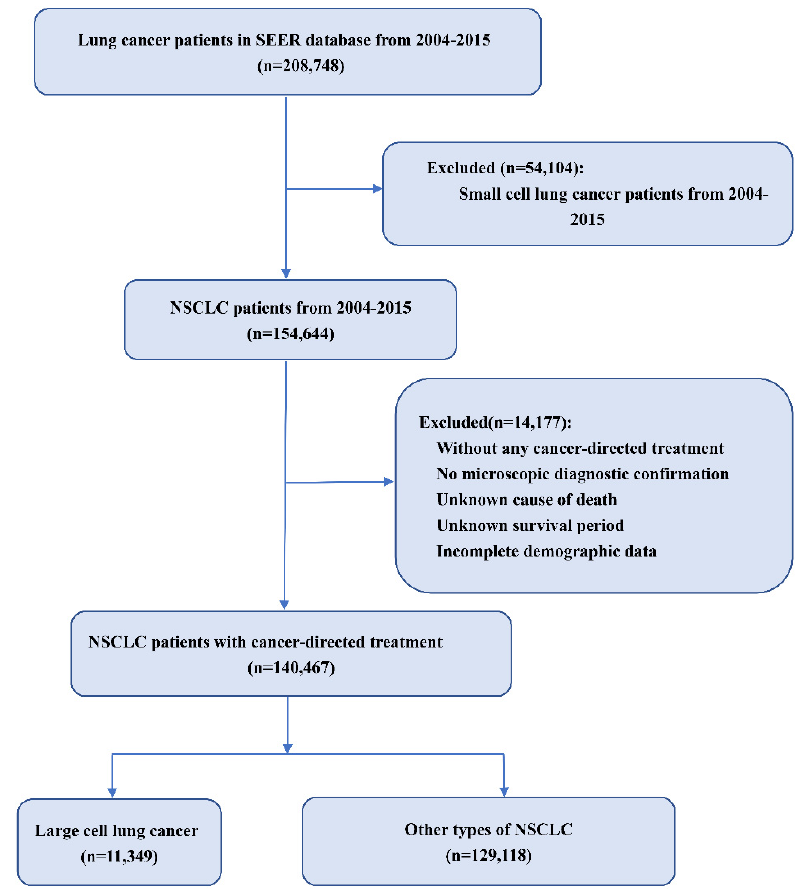
Figure 1. Flow chart of patient screening. Abbreviation: LCC: large cell carcinoma; NSCLC: non-small lung cancer.